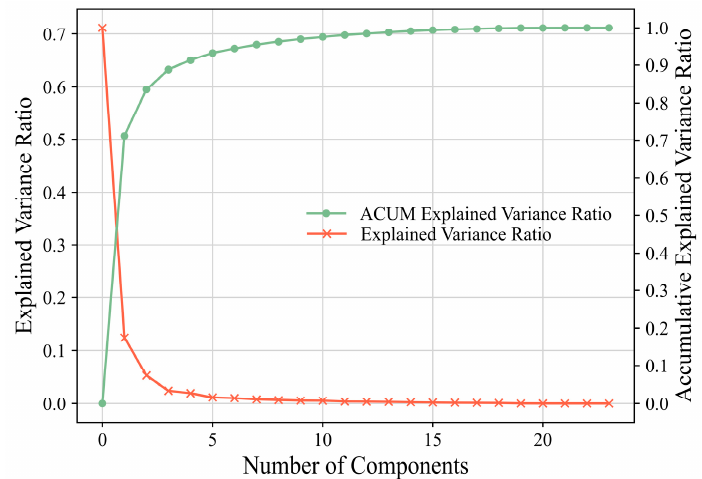
Figure 6. Scree plot of the components, the green line represents the accumulative explained variance ratio, the red line represents the explained variance ratio of each component.